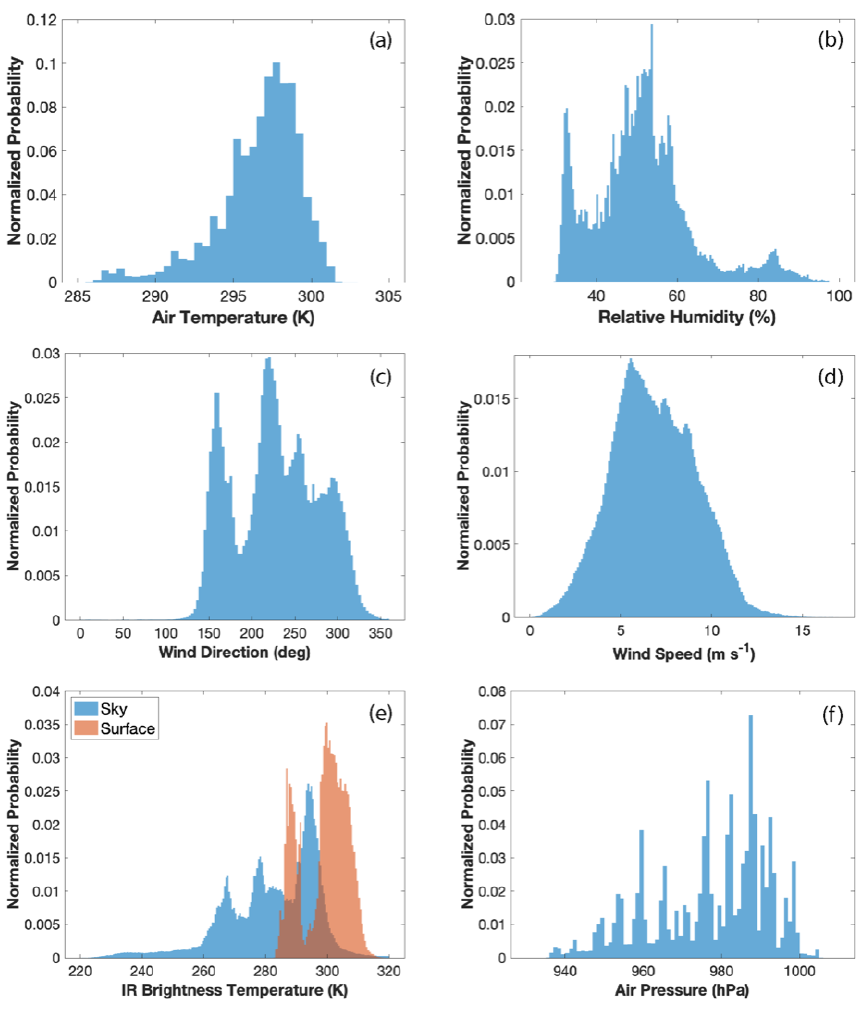
Figure 7. Histograms of (a–f) temperature, relative humidity, wind direction, wind speed, IR brightness temperatures, and air pressure, as measured by the RAAVEN during WiscoDISCO-21. As in Fig. 6, the “normalized probability” presented for a given bin is the number of elements in a given bin divided by the total number of elements in the input data, so that the integral of the histogram equals 1.